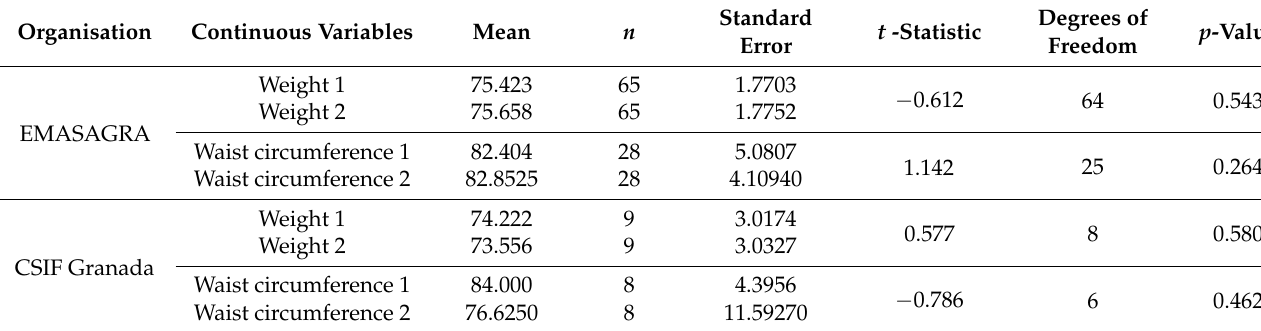
Table 5. Weight and waist circumference paired sample analyses (Student’s t